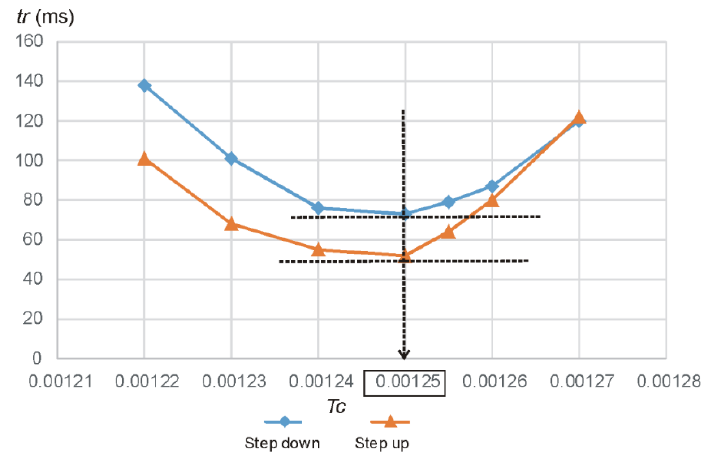
Figure 5. Response time t r in ms of the proposed MPPT method, measured for falling irradiance from 1000 to 800 W/m 2 —step down and rising irradiance from 800 to 1000 W/m 2 ; step up for given integration constant time T c .